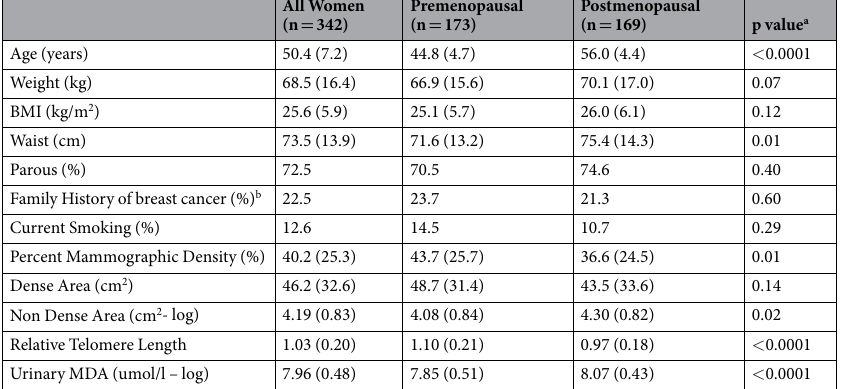
Table 1. Selected characteristics of subjects. Continuous variables are presented as mean (SD) and categorical variables as percentage. a p value for comparison of pre and postmenopausal women. Two-sided two-sample t-test for continuous variables and Chi square test for categorical variables. b Percentage of subjects with at least one first degree family member with breast cancer.